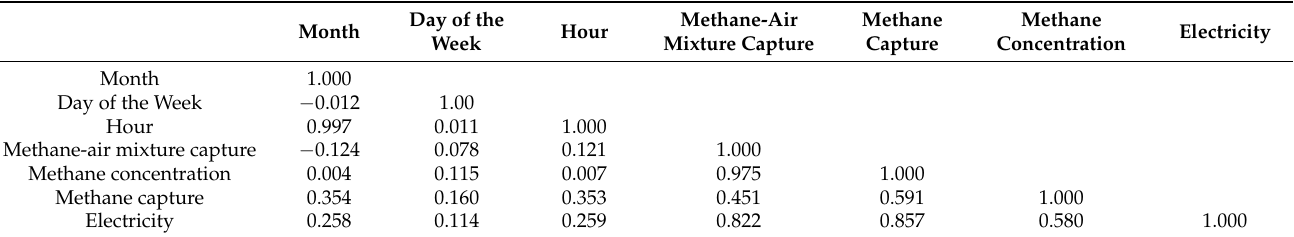
Table 5. Matrix of the correlation